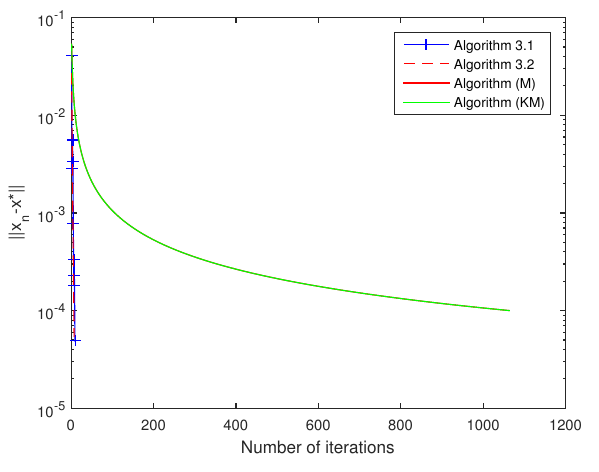
( sin ( − 3 ∗ t )+ cos ( − 10 ∗ t )) 300